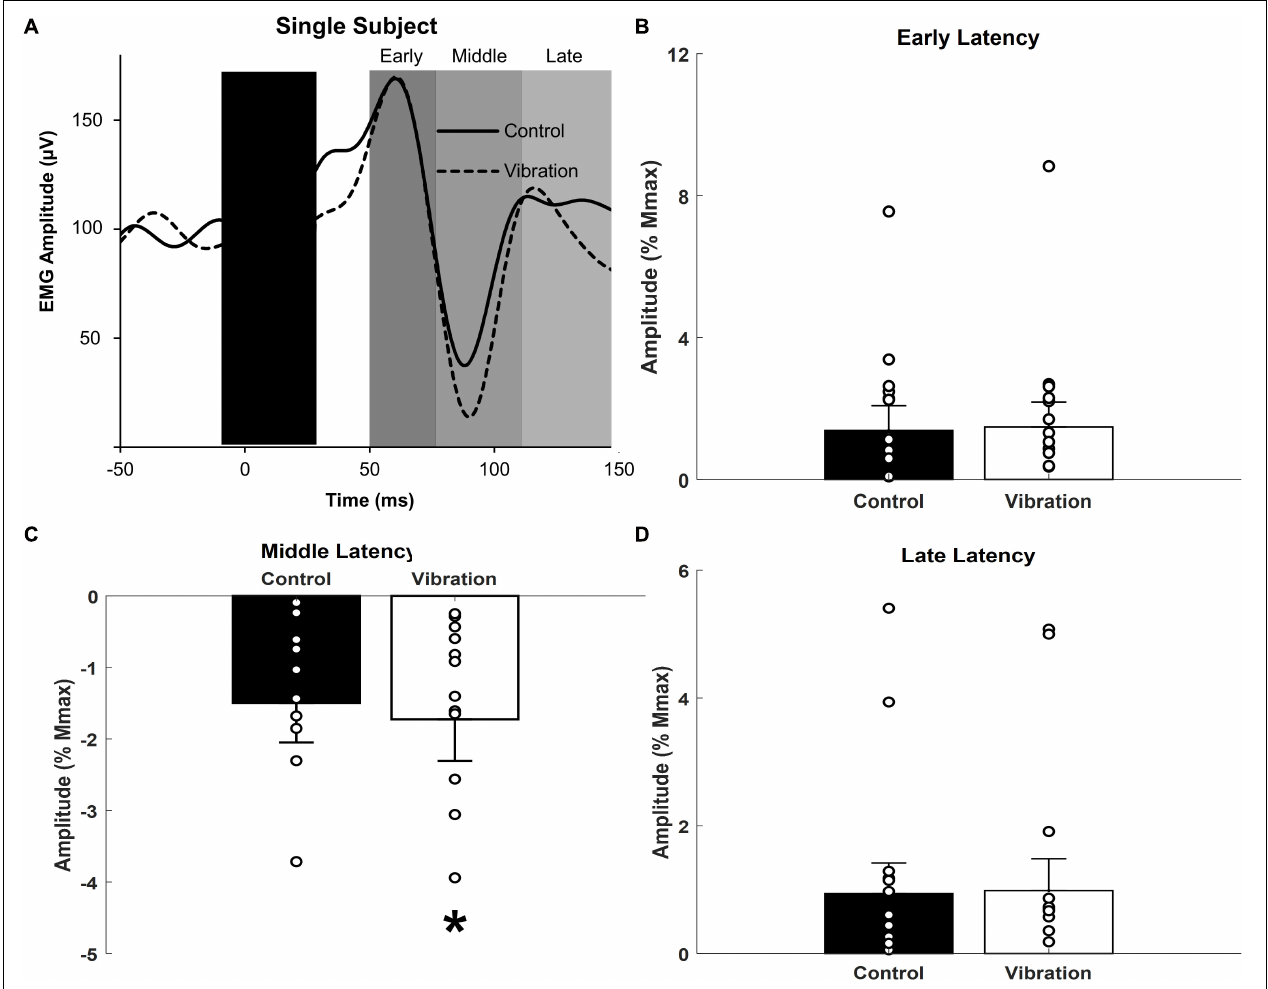
FIGURE 5 | Effects of upper limb vibration on cutaneous reflex amplitude. (A) Single subject traces providing representative examples of cutaneous reflexes. Solid traces indicate the average of 20 sweeps during CONTROL, whereas dotted traces indicate the average trace during ULV. (B) Group average across conditions of early latency cutaneous reflex amplitude. (C) Group average across conditions of middle latency cutaneous reflex amplitude. (D) Group average across conditions of long latency cutaneous reflex amplitude. All single subject data is included as clear circles. * Indicates significant reduction in middle latency cutaneous reflex amplitude during ULV. Values are mean ± SD ( p <